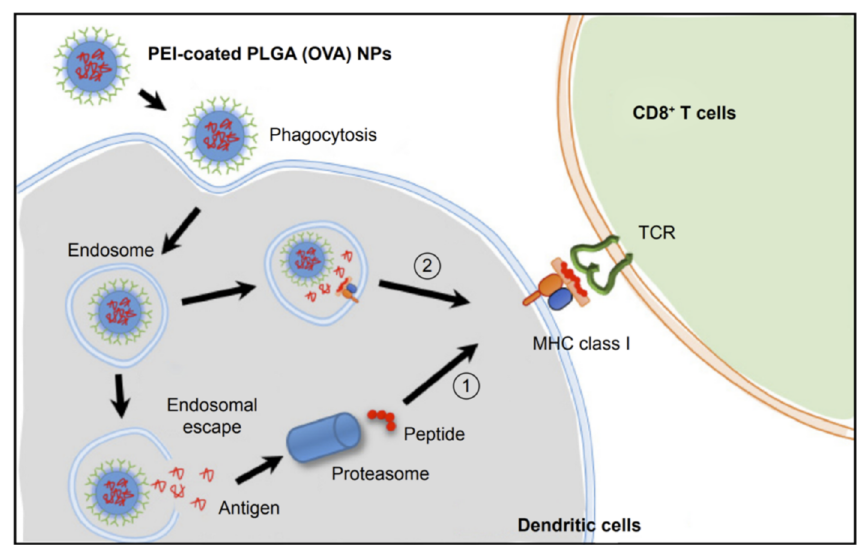
Figure 4. Schematic illustration of the predicted mechanism of cross-presentation and CD8 + T- cell response induced by PEI-coated PLGA (OVA) NPs. Notes: OVA encapsulated in PEI-coated PLGA (OVA) NPs entered the DCs through phagocytosis or macropinocytosis, and then (1) OVA escaped and was released from an endosome. The released OVA was processed by a proteasome and presented by MHC class I molecules. (2) OVA was processed by a lysosomal protease in an endosome and cross-presented by MHC class I molecules. Abbreviations: DCs, dendritic cells; PEI, polyethylenimine; PLGA, poly(d,l-lactide-co-glycolide); OVA, ovalbumin; NPs, nanoparticles; MHC, major histocompatibility complex; TCR, T-cell receptor. (Adapted from